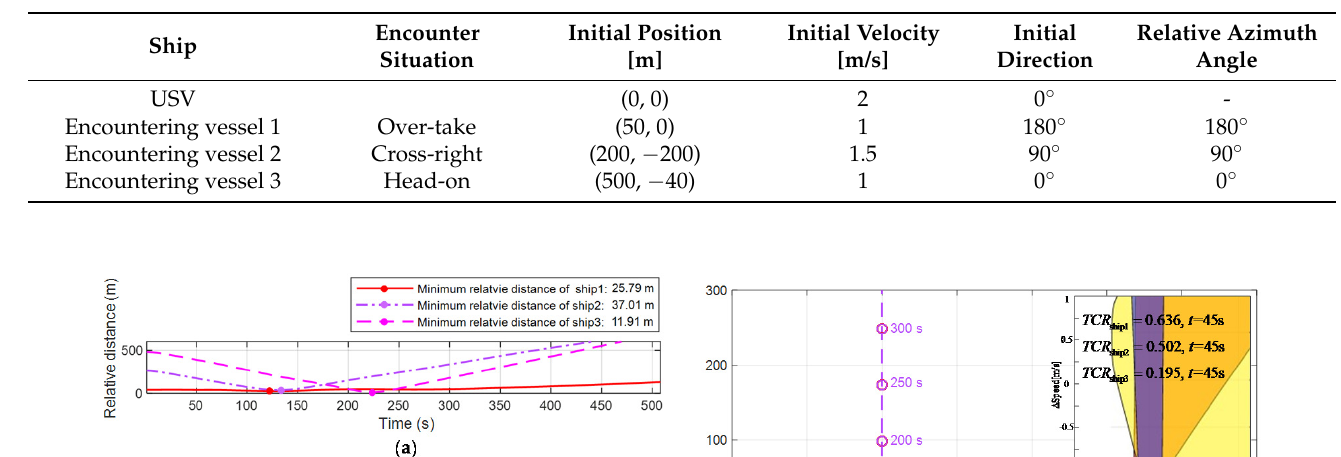
Table 8. Settings of encounter scene parameters.